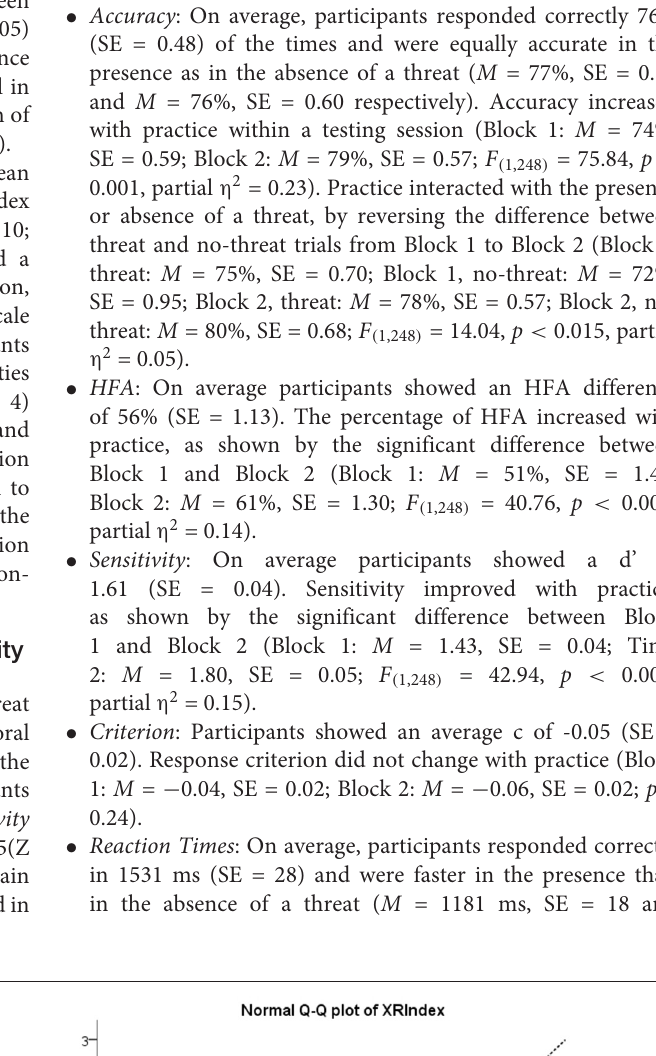
Frontiers in Human Neuroscience |